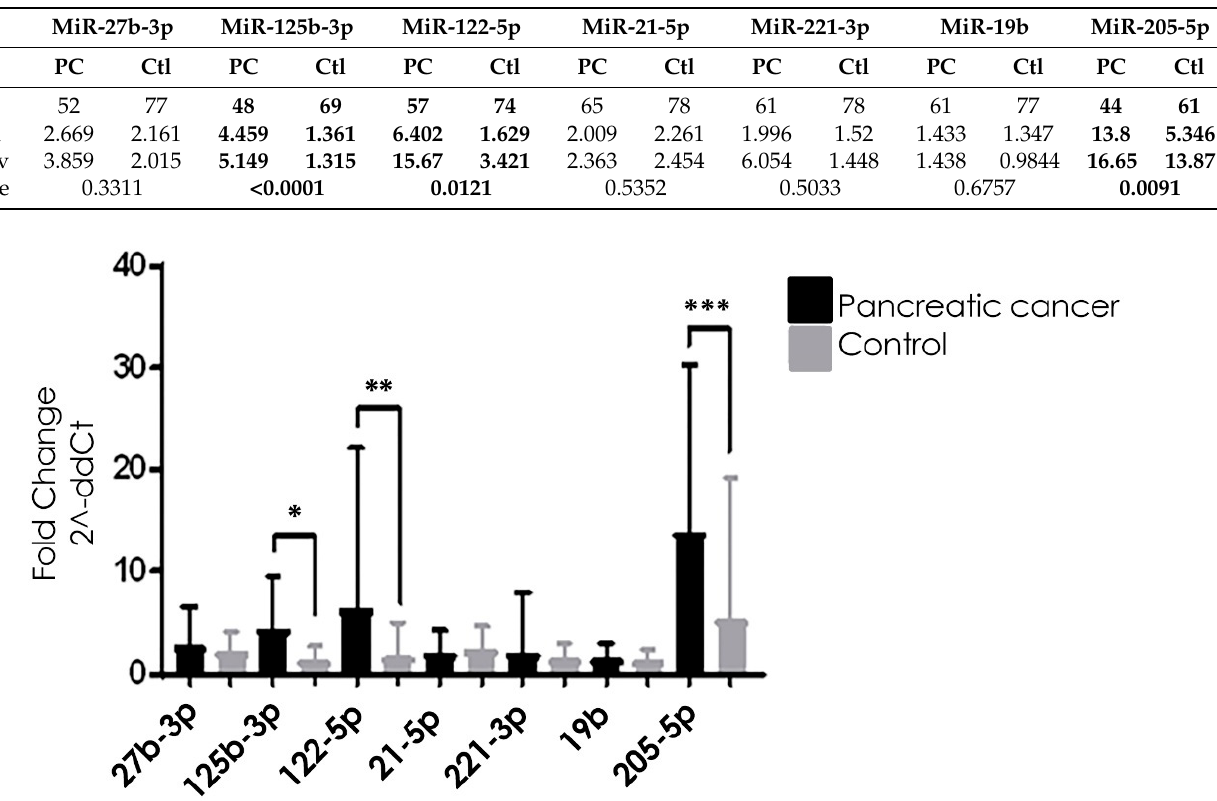
Figure 2. Relative microRNA expression comparison between pancreatic cancer and healthy control groups. miR-125b-3p*, miR-122-5p**, and miR-205-5p*** were expressed significantly higher in pancreatic cancer groups than healthy control groups (* p <0.0001; ** p = 0.0121; *** p = 0.0091). Additionally, exosome-derived miRNA expression was analyzed according to the type of cancer, ethnicity, tumor progression, and vital status. Table 4 shows that miR-125b-3p, miR-122-5p, and miR-205-5p were significantly overexpressed in pancreatic adenocarci- noma patients than in other types of pancreatic tumors, such as IPMN, Frantz Tumor and PanNET. Interestingly, miR205-5p was significantly overexpressed only in European descendants, patients with tumor progression, and those who died from the